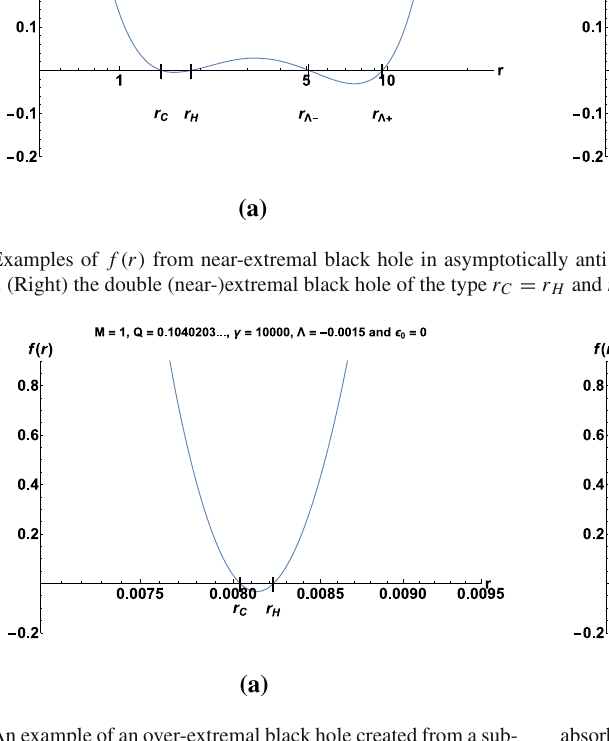
absorbed by the sub-extremal black hole. (Left) the sub-extremal black hole before absorbing the charged particle. (Right) the over-extremal black hole after absorbing the charged